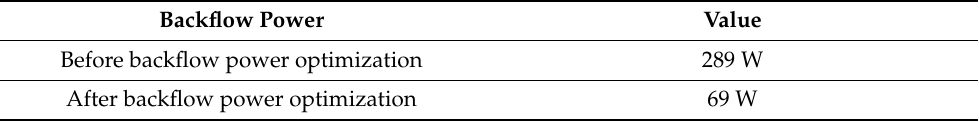
Table 4. Backflow power of converter.